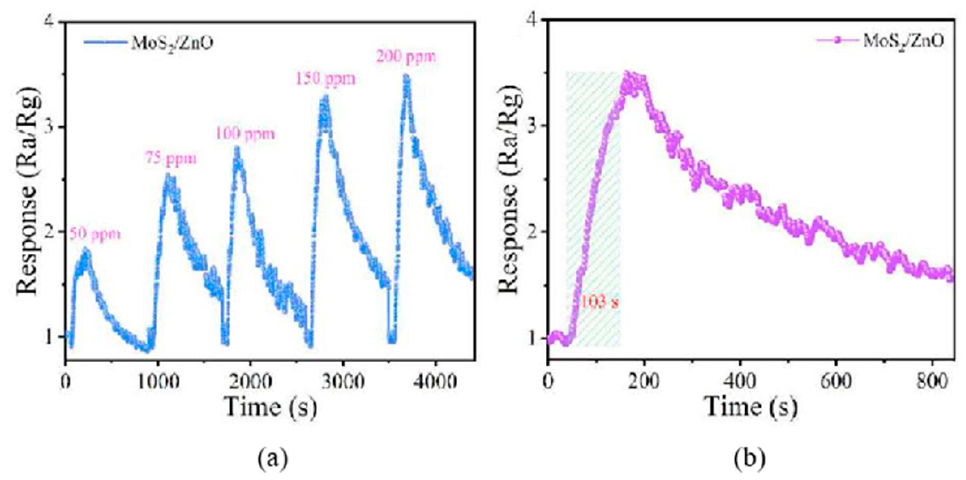
Figure 22. ( a ) The response curves of MoS 2 /ZnO to different concentrations of TEA at room temperature. ( b ) The response–recovery curve of MoS 2 /ZnO to 200 ppm TEA at room temperature [135]. Hao et al. [144] modified porous LaFeO 3 microspheres with RGO following a simple electrostatic self-assembly strategy. Figure 23a shows the sensing mechanism that the tight interface contact between LaFeO 3 microspheres and RGO tablets. RGO is wrapped on the surface of the microspheres to form p-p heterojunctions, causing the adsorbed oxygen to trap free electrons from the conductive band, in turn making the electrical resistance decrease. Figure 23b reveals the excellent selectivity of LaFeO 3 , RGO/LaFeO 3 nanomaterials to 100 ppm of five different VOCs at 240 ◦ C.